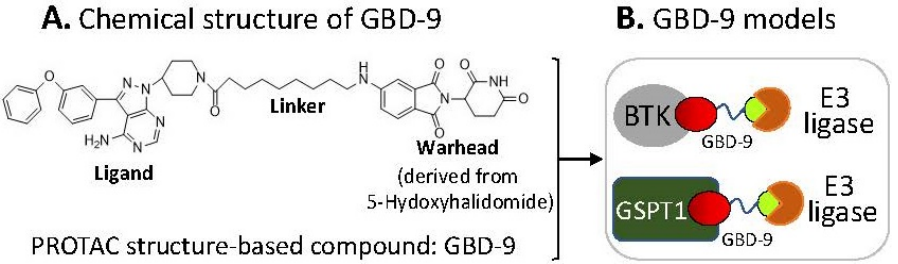
Figure 8. ( A ) Chemical structure of the GBD-9 compound; ( B ) cartoon models for the GBD-9 ligand part to find two distinct neosubstrate proteins (BTK, GSPT1) for polyubiquitination by E3 ligases. Then, the polyubiquitinated proteins would be degraded through the ubiquitination proteasome pathway.